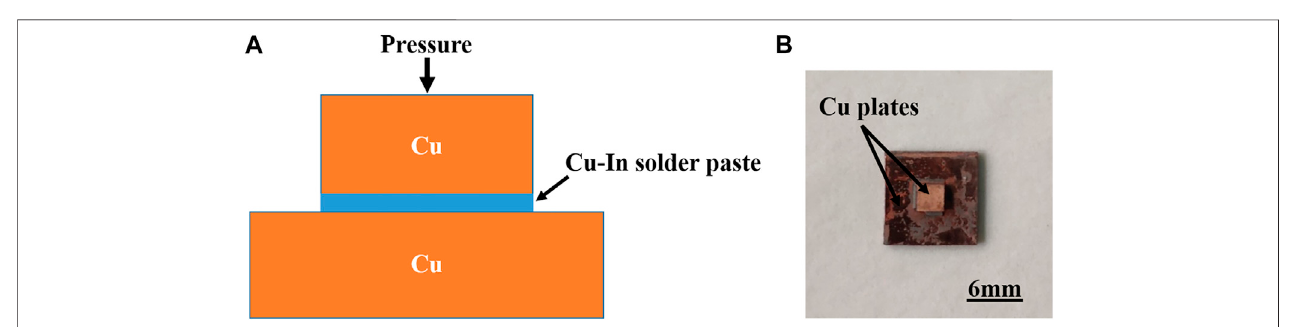
FIGURE 2 | Cu/Cu-In/Cu sandwich structure: (A) Schematic diagram and (B) Macroscopic photo.